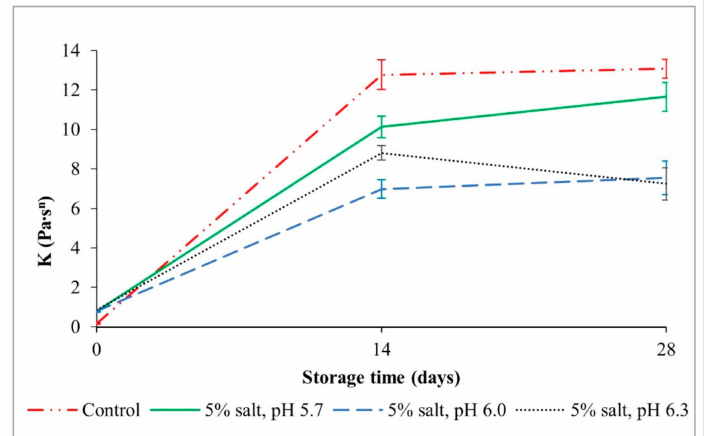
Figure 10. The effect of treatment on the yield stress ( τ 0 ) of frozen-thawed liquid egg yolk. Data are presented with mean ± standard deviation.